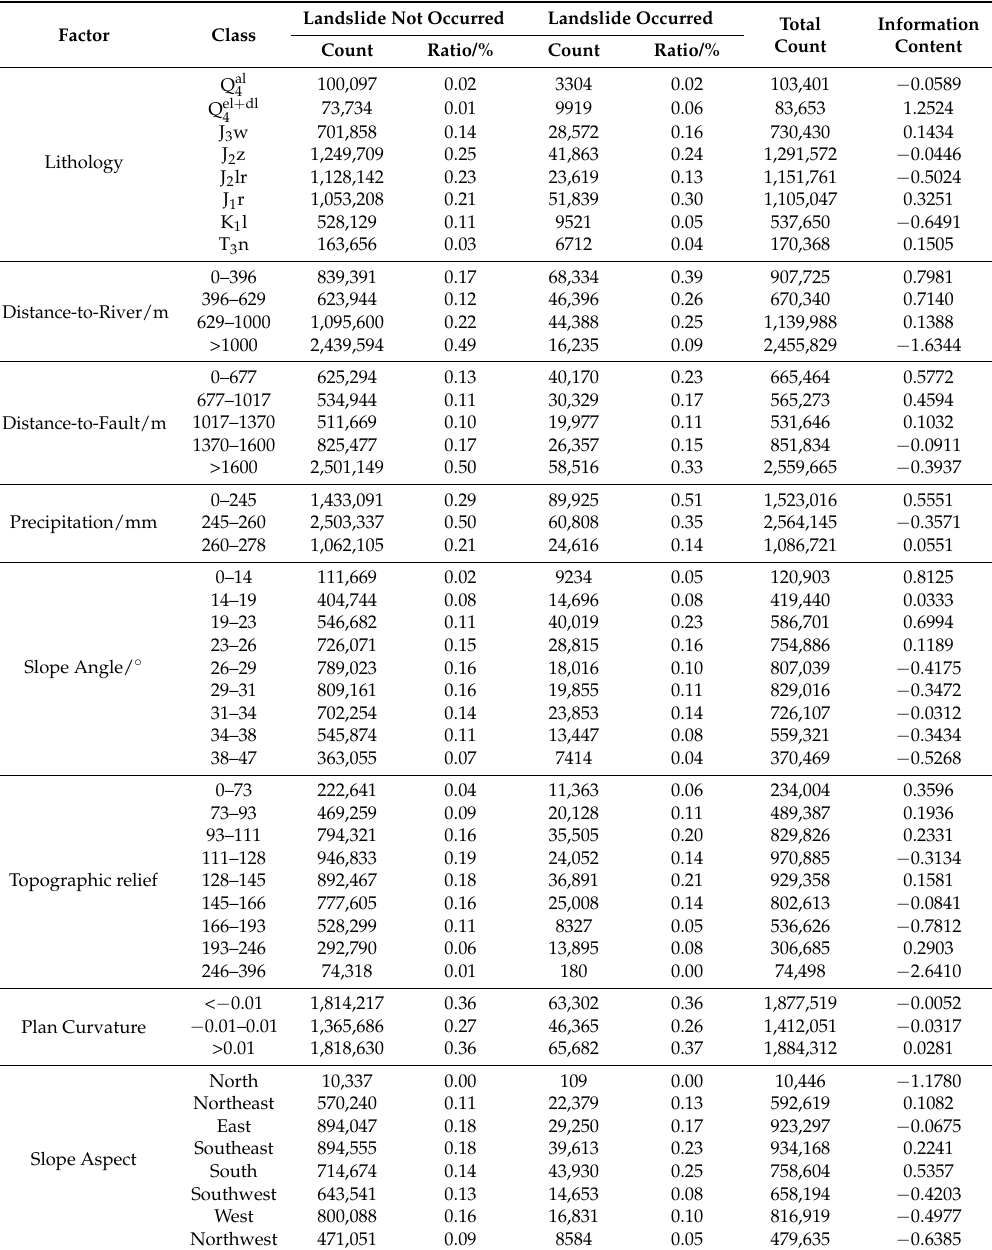
Table 4. Distribution of the training